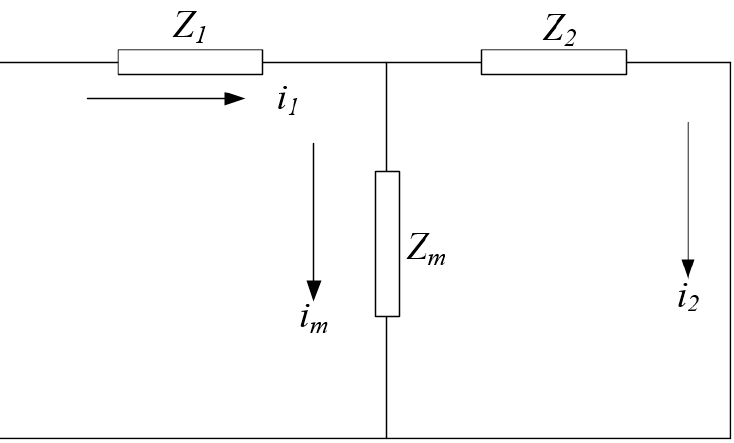
Figure 1. Circuit model of GIS.